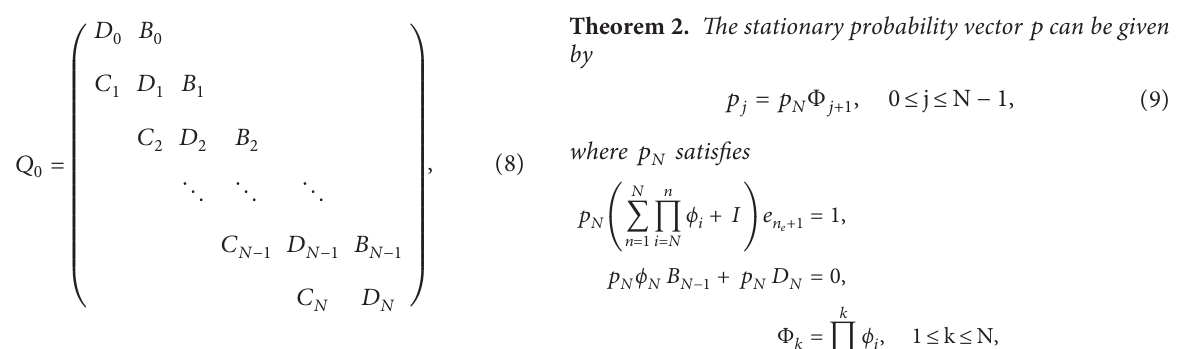
Figure 1: Transition rate diagram of the observable